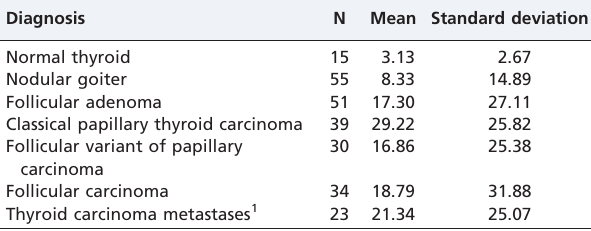
Table 1 - Quantitative analysis of NDRG1 immunohistochemical expression in thyroid lesions.